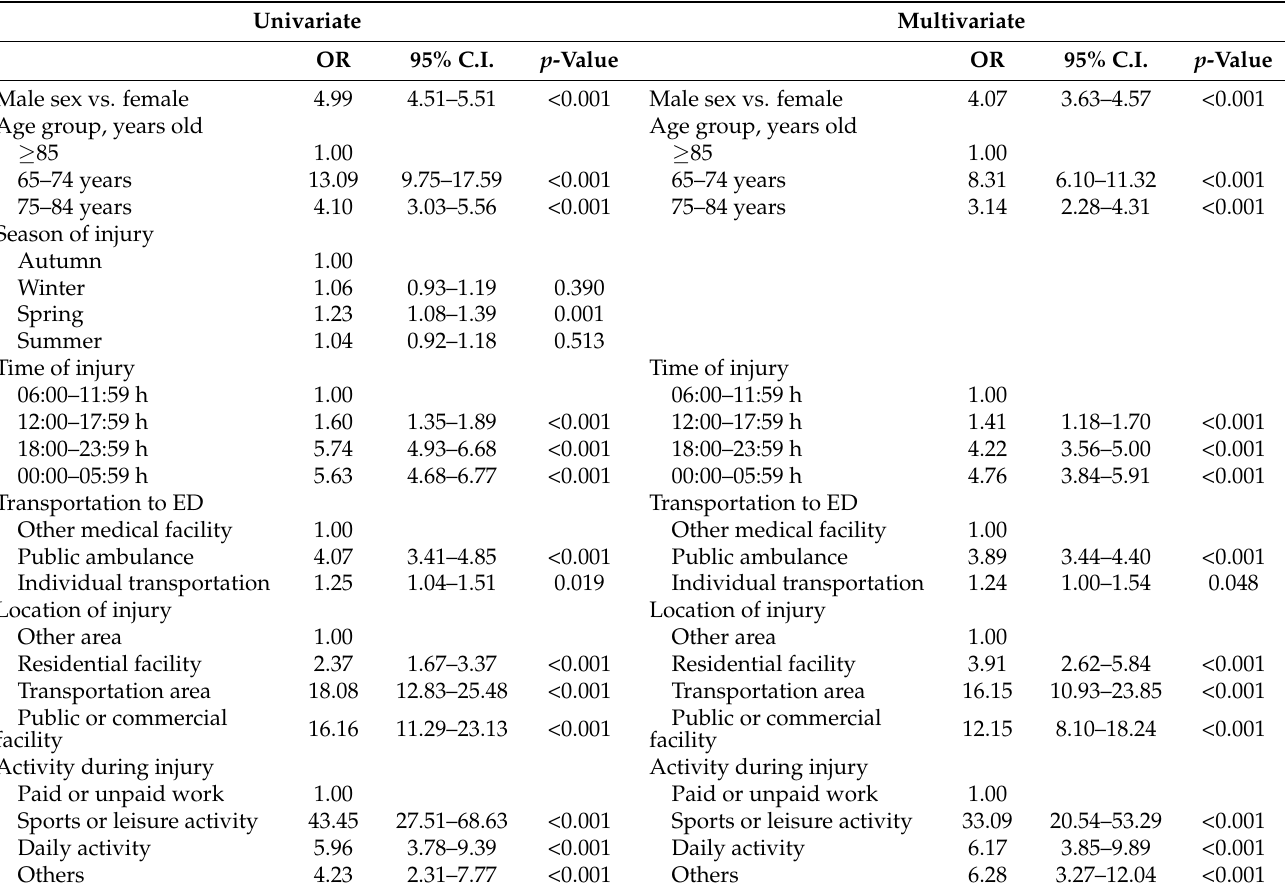
Table 2. Factors associated with alcohol intake and ground-fall injuries in the